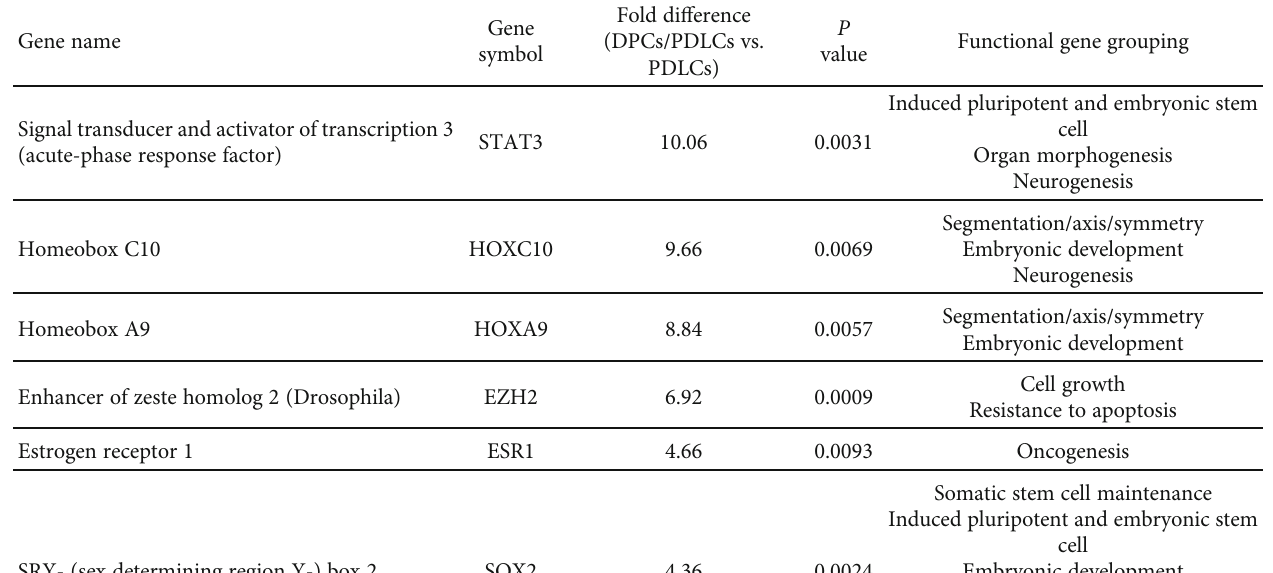
Table 5: List of genes with altered expression with PDLCs with indirect